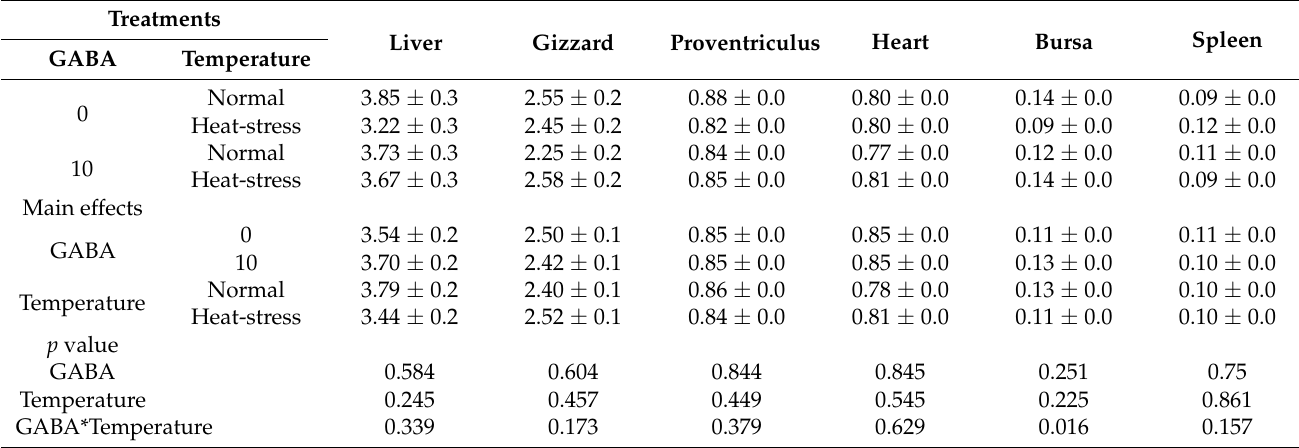
Table 6. Effect of in ovo injection of GABA on relative organ weight (g/100g BW) of 10-day-old chicks exposed to acute heat stress for 3 h.